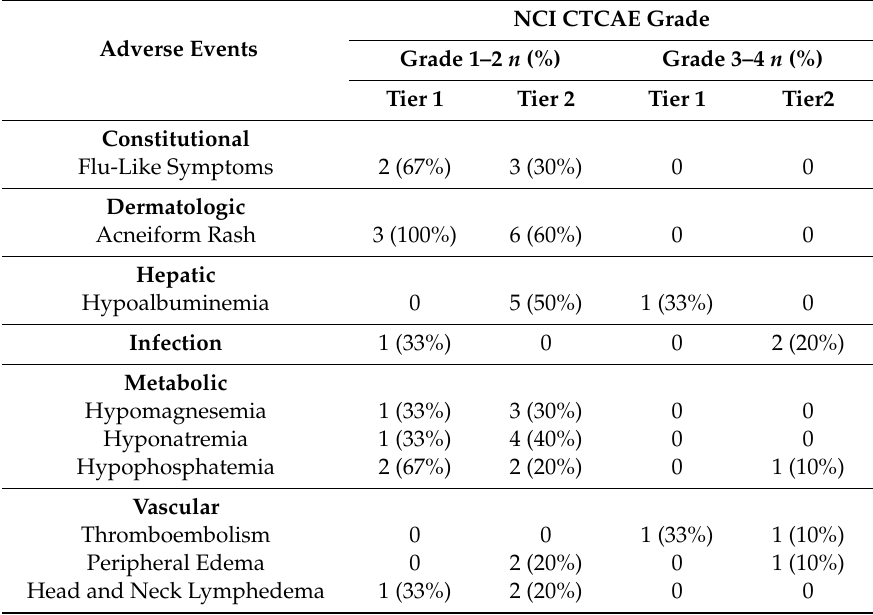
Table 2. Adverse events related to cetuximab plus ficlatuzumab by dose tier and grade in all patients that received at least one dose of drug ( n = 3 at Tier 1; n = 10 at Tier